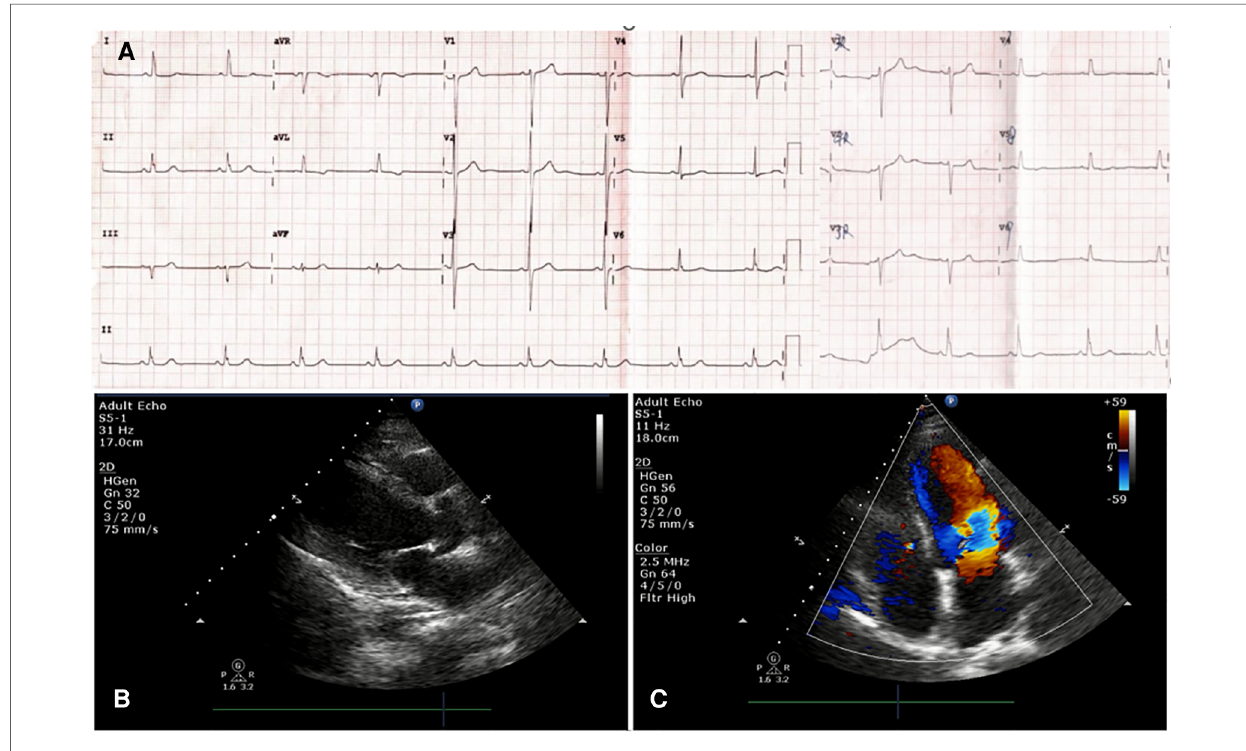
FIGURE 1 Emergency electrocardiogram (ECG) was performed at rest showed normal sinus rhythm with no signi fi cant ST-T changes in all leads ( A ); Echocardiography in ER indicated a mildly thickened ventricular septum and left ventricular posterior wall, mild tricuspid regurgitation and a slightly reduced left ventricular ejection fraction (LVEF 50%) ( B and C